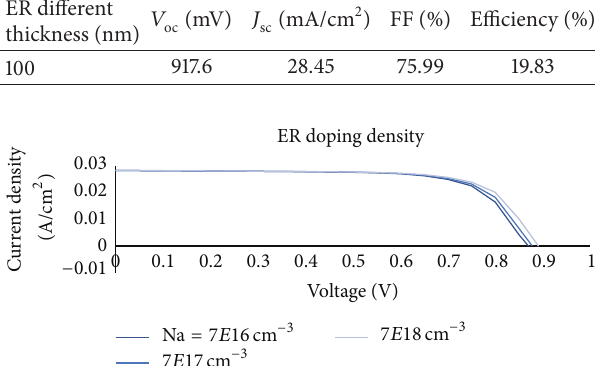
Table 5: Cell efficiency with ER layer thickness of 100nm and doping density of 7×10 18 cm − 3 . Abarrierheight of 0.1eVis assumed.